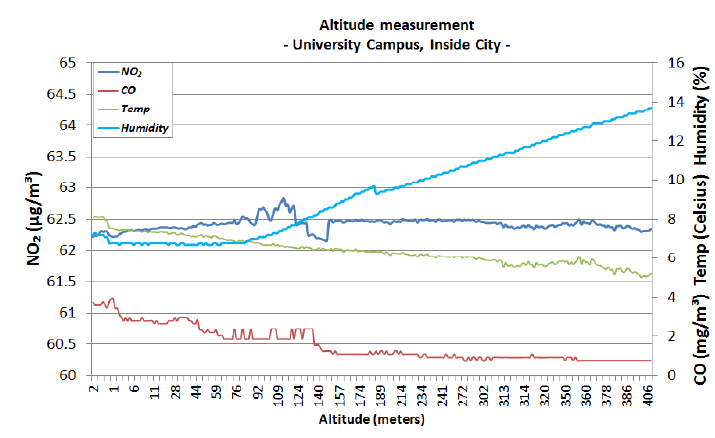
Figure 10. University area, sunny day, autumn, 400 m